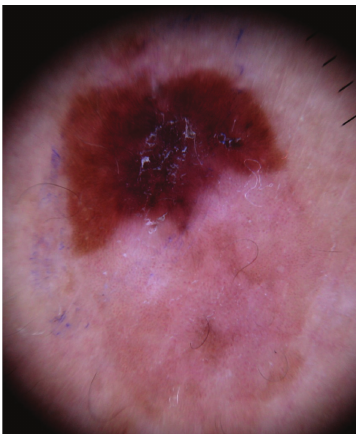
Figure 5: Dermoscopy in Case 1 shows central structureless brown and blue-gray pigmentation with keratosis, irregular peripheral pig- mented streaks and brown regular globules in a linear arrangement. On the lower two thirds, light brown regular globules in linear and clustered arrangement, patches of clustered glomerular vessels, and a structureless hypopigmented central area.